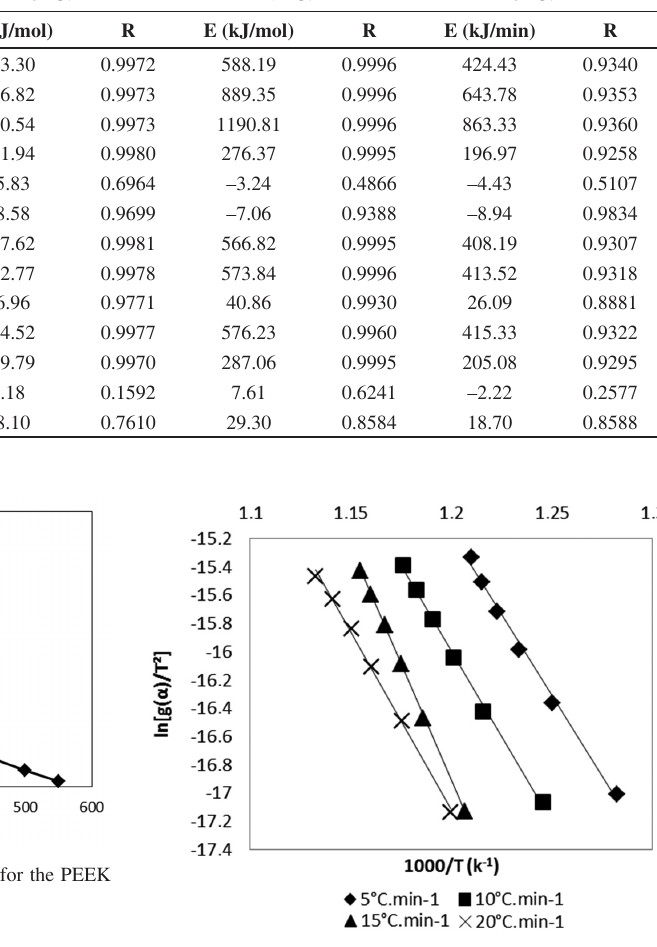
Table 5. Activation energies for the heating rates of 5 °C.min –1 ; 10 °C.min –1 ; 15 °C.min –1 and 20 °C.min –1 in air atmosphere.